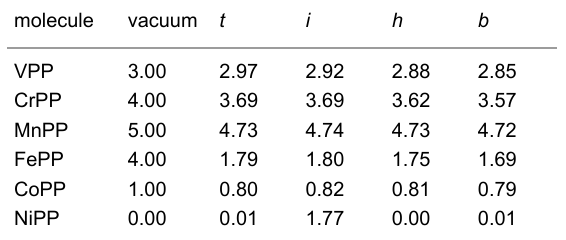
Table 1: Magnetic moments, expressed in μ B , for all TMPP systems in vacuum and all adsorption positions.